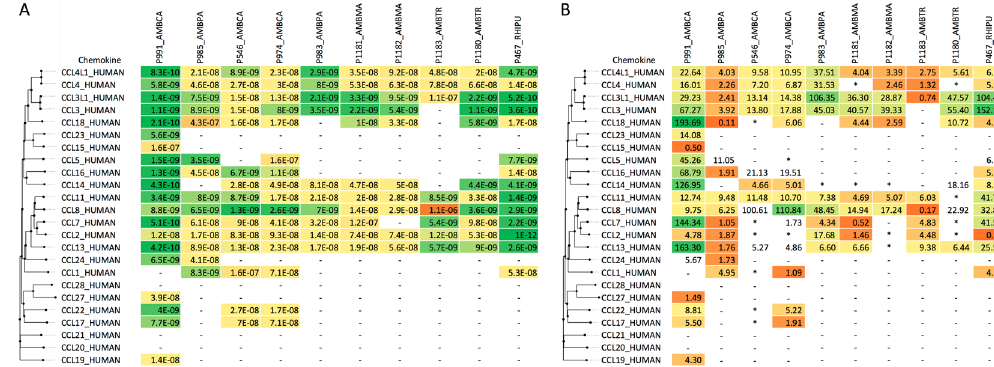
Figure 5. Binding of novel evasins to human CC chemokines. ( A ) Binding affinities ( K d , moles/litre) of novel evasins to human CC-chemokines using biolayer interferometry. Higher affinity binding is indicated as shades of green, medium affinity as yellow, and lower affinity as shades of orange. Evasins and chemokines are arranged by sequence-similarity based phylogeny. - Indicates that binding was not detected at 300